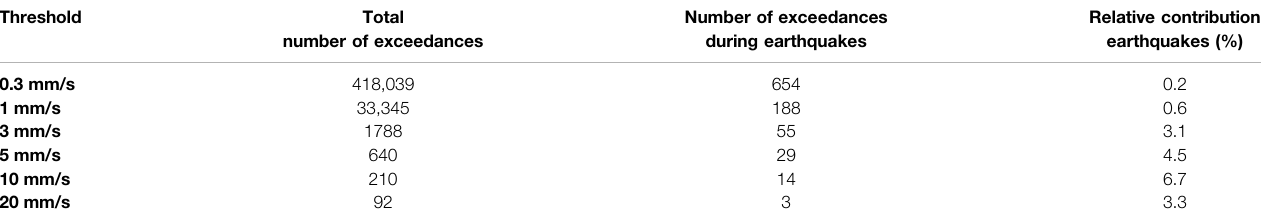
TABLE 6 | The total number of exceedances in the monitoring network of the selected velocity threshold levels for the full operational period with and without earthquake events. Threshold Total number of exceedances